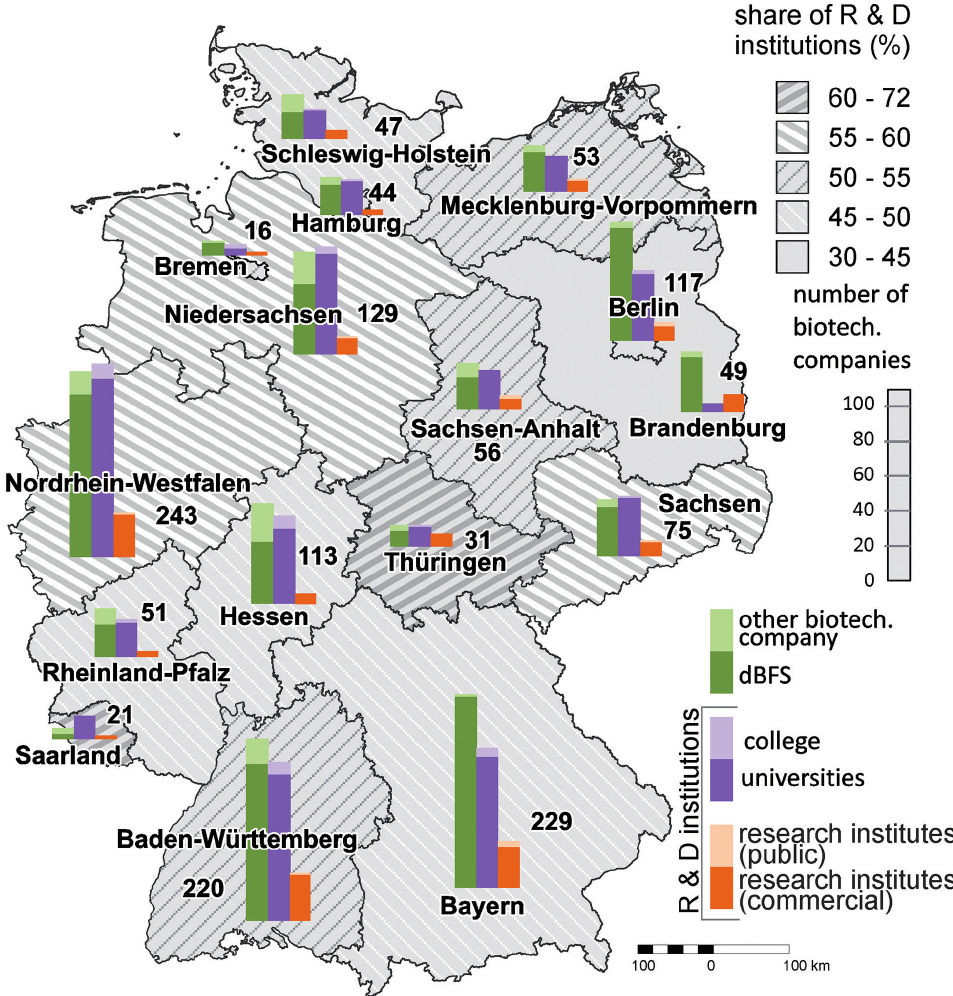
Fig. 10. Structure of biotechnology centres in the regions of Germany, 2013 Source: own calculations based on the Internet portal